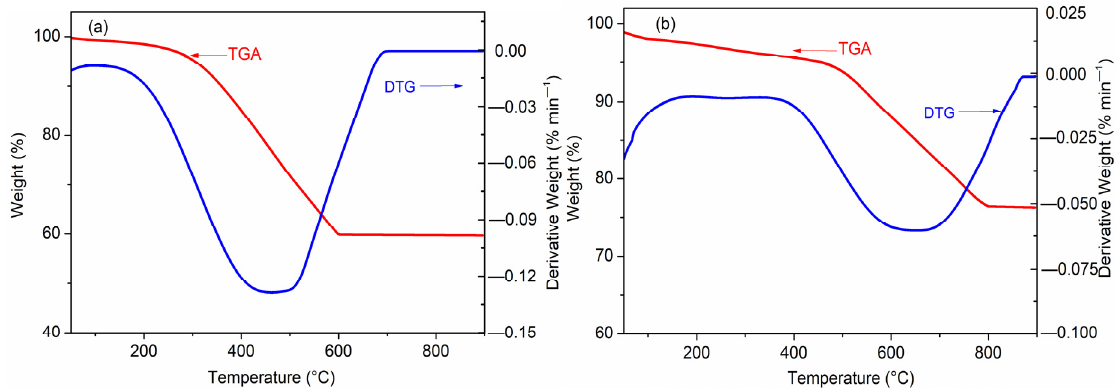
Figure 4. TGA-DTG thermograms for the ( a ) BC and ( b ) FBPC 2.5-900-2% samples under an N 2 flow that was similar to that of the activation process.